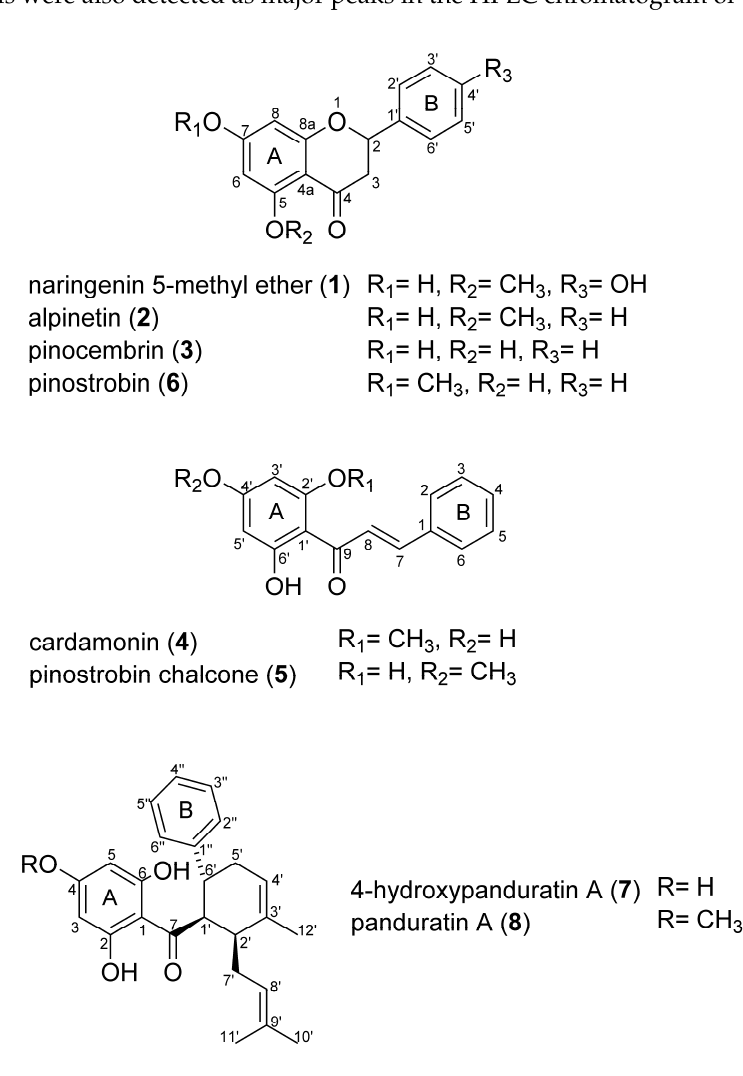
Figure 3. Structures of compounds isolated from B. rotunda rhizomes.